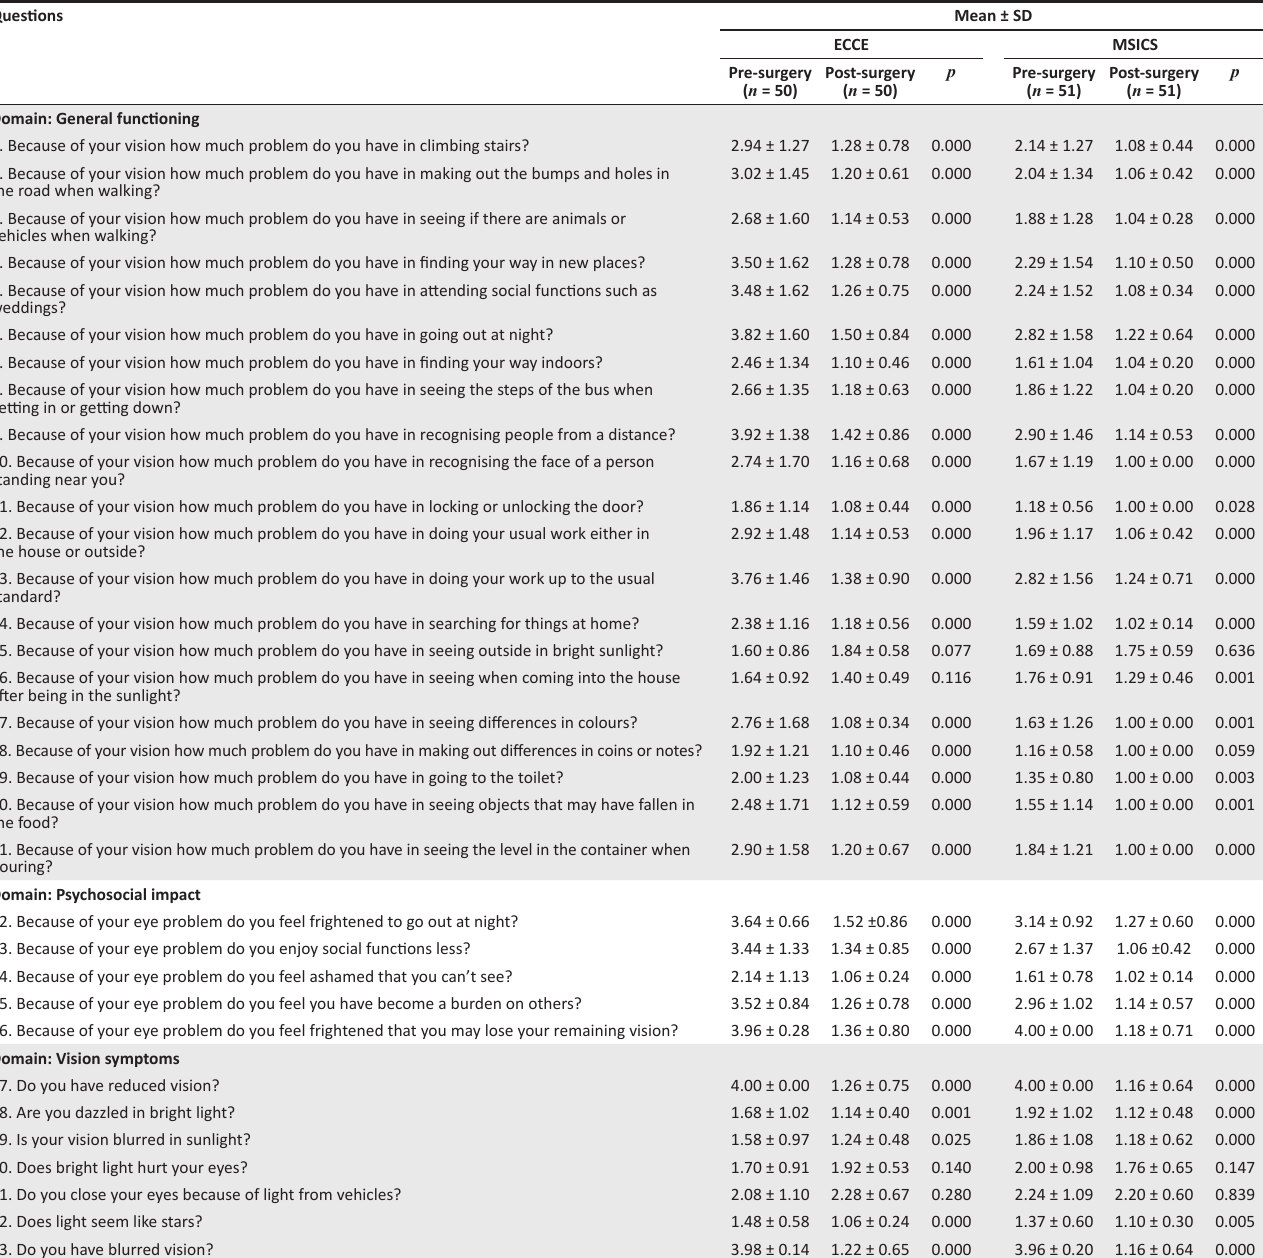
TABLE 3: Mean ± standard deviation of vision-related quality of life responses (pre-surgery and post-surgery) for participants undergoing the extracapsular cataract extraction surgery and manual small-incision cataract surgery cataract surgery techniques using the 33-item Indian Vision Functioning Questionnaire.